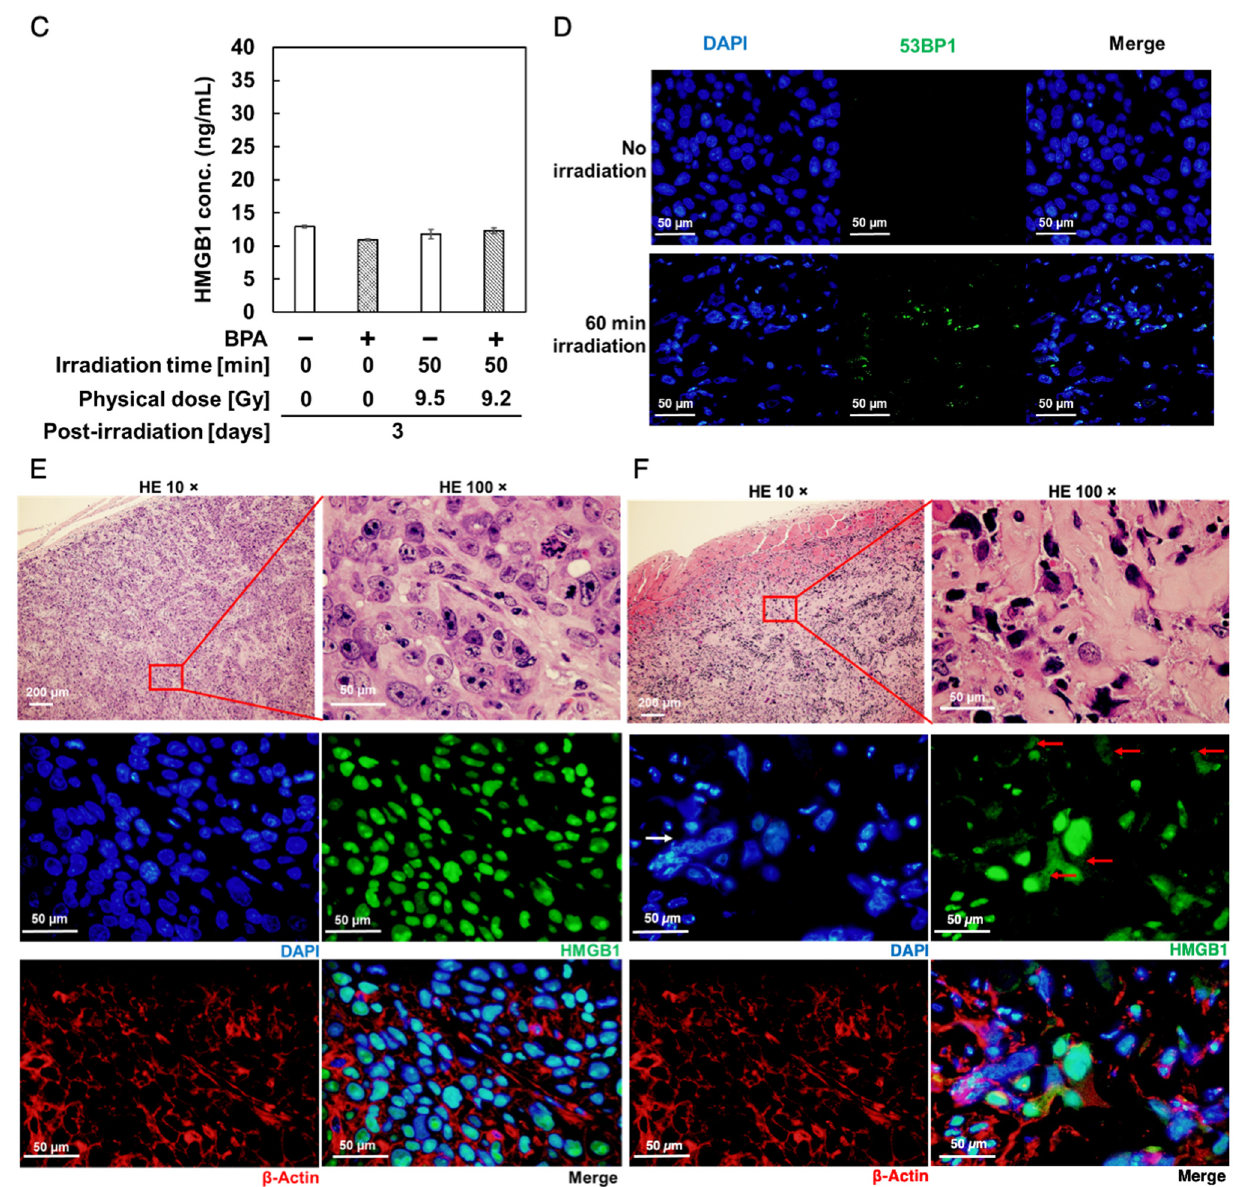
Figure 4. Changes in HMGB1 levels and localization in response to neutron irradiation with BPA in SAS cell-derived tumors. SAS cells were subcutaneously grafted in nude mice and 30 min after administration of BPA–fructose at 500 mg/kg bodyweight, tumors were mock-irradiated ( E ) or locally irradiated for 60 min with neutron beam, (( F ), BNCT). ( A ) Changes in tumor volumes in response to neutron irradiation after BPA administration. Data are presented as mean ± S.E. *, p < 0.05. ( B ) Mea- surement of plasma levels of human HMGB1 in mice using ELISA (Abnova). ( C ) Mouse plasma HMGB1 levels of C57BL/6 mice without tumor xenograft 3 days after mock irradiation or BNCT mea- sured using ELISA kit (Novus Biologicals). The BNCT group was administered with BPA–fructose at 500 mg/kg bodyweight 30 min before whole-body neutron irradiation. ( D ) Immunostaining of 53BP1 in sections from tumor xenografts of ( A ) at day 3. Bars in ( D ), 50 µ m. ( E , F ) Immunostaining of the HMGB1 (green) and β -actin (red) in sections from tumor xenograft-bearing mice at day 3. Bars, 200 µ m (top, left panel) and 50 µ m (other panels). In ( F ), HMGB1 panel, solid red arrow shows the distribution of HMGB1 in the cytoplasm; solid white arrow shows the irregular nuclear morphology. Day 3: mock irradiation, n = 7; BNCT group, n = 7. Day 8: mock irradiation, n = 4; BNCT group, n = 4. Physical dose at the skin was estimated to be 6.5 Gy in the BNCT group. For counterstaining of nuclei, 4 (cid:48) ,6-diamidino-2-phenylindole (blue) was